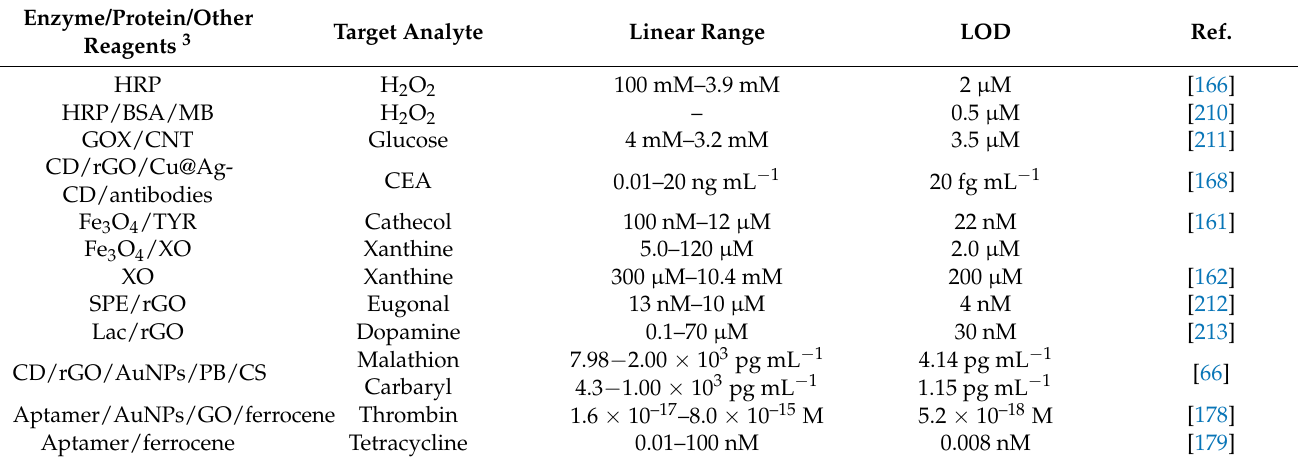
Table 4. A selection of some of the biosensors using CDs or functionalized CDs as a supramolecular recognition unit. Enzyme/Protein/Other